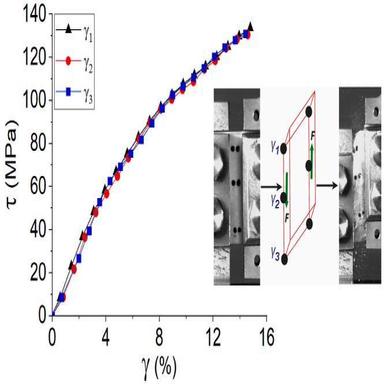
Shear stress-strain curves for HO-A-SMC composite: monitoring the 6 points.